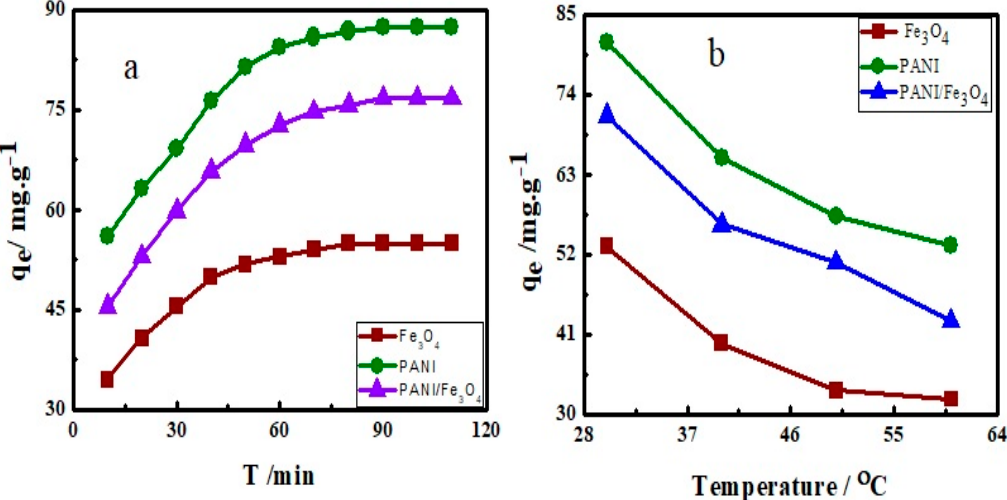
Figure 7. Effect of ( a ) time and ( b ) temperature on adsorption of AB40 onto Fe 3 O 4 , PANI and PANI/Fe 3 O 4 composite.